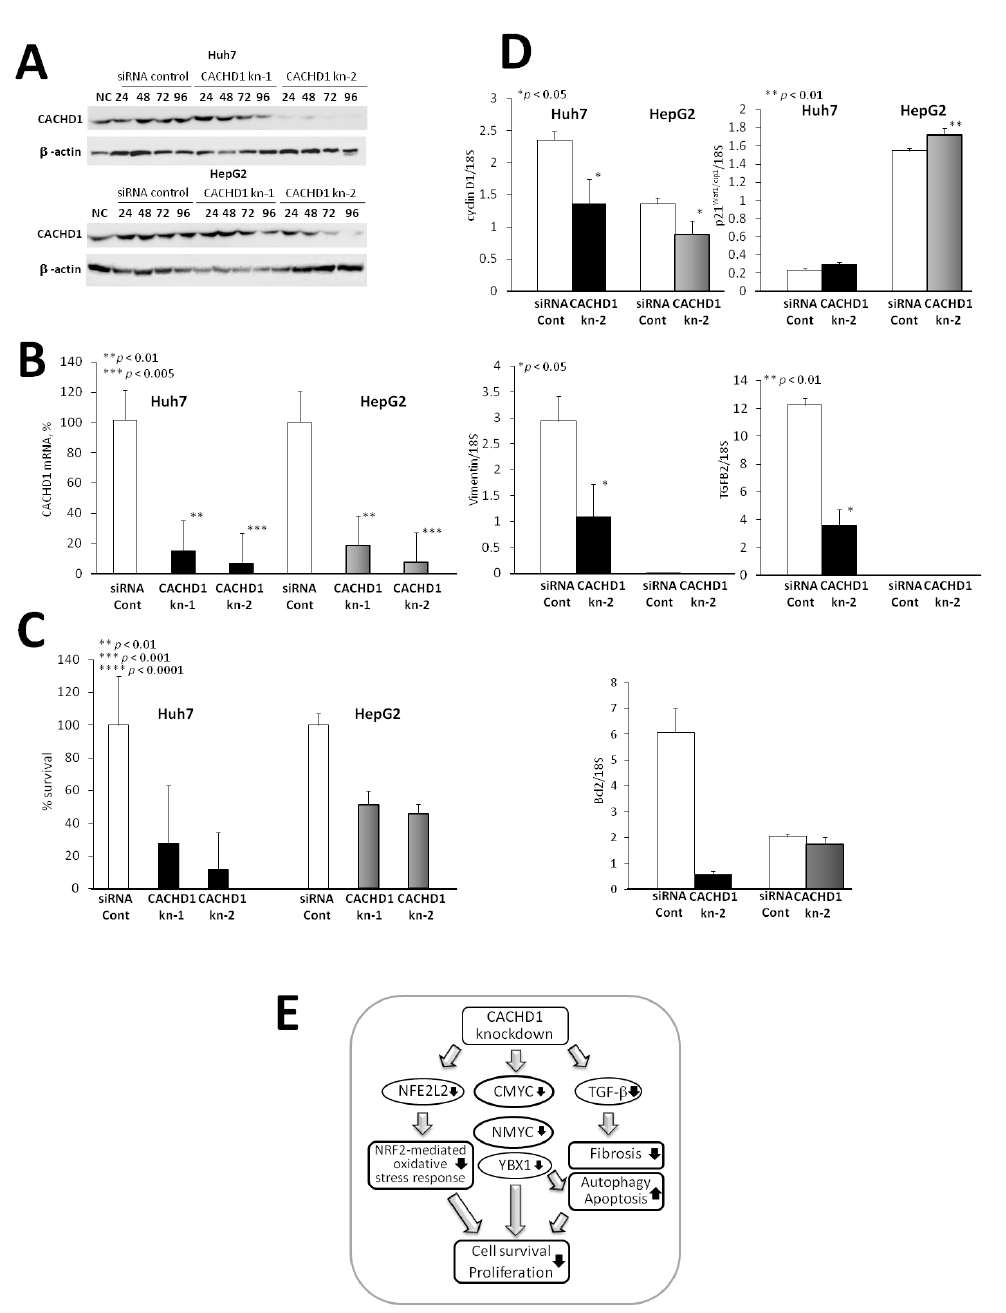
Figure 3. Effects of CACHD1 siRNA knockdown in Huh7 and HepG2 human hepatoma cell lines. Western blot ( A ) and RT-PCR analysis ( B ) of CACHD1 expression, ( C ) cell viability detected by WST8 assay, ( D ) cyclin D1 and p21 Waf1/Cip1 mRNA expression in CACHD1kn-2 cell lines, and ( E ) results of upstream regulator and pathway analysis by IPA in CACHD1kn Huh7/HepG2 cells. Note the significant suppression of cell viability, decrease of cyclin D1 and elevation of p21 Waf1/cip1 mRNA expression in CACHD1kn cell lines. Uncropped Western Blot of subfigure ( A ) is available in Figure